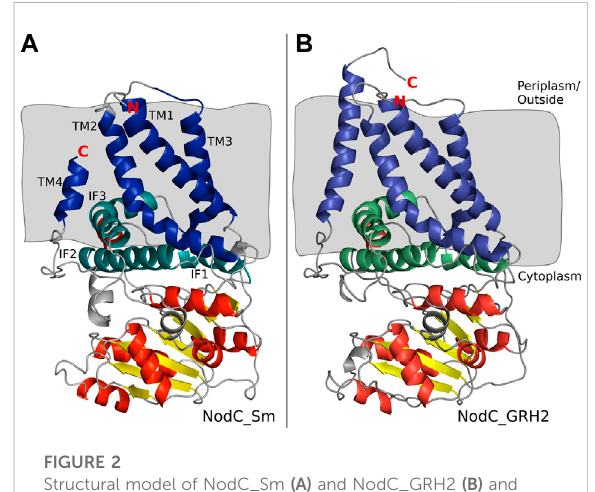
FIGURE 2 Structural model of NodC_Sm (A) and NodC_GRH2 (B) and their position within the membrane. (A) Blue and green highlight the exact regions identi fi ed as transmembrane domains (TM1-4, dark blue) or cytoplasmic interface-leaning helices (IF1-3, green) by Dorfmueller et al. (2014). Grey background represents the membrane. The coloring of the cytoplasmic secondary structures, the yellow β -sheets and red α -helices, as well as the indication of the N- and C-terminus with red letters are adapted from the paper (Dorfmueller et al., 2014). In comparison to the published NodC_Sm, our model shows two short extra helices in the cytoplasm (grey). (B) Coloring of NodC_GRH2 was made accordingly and visualizes the high similarity to